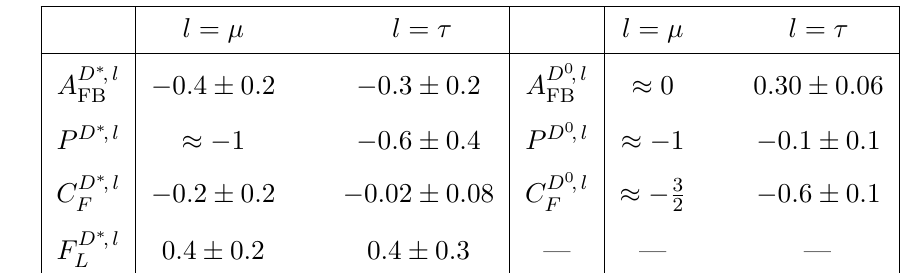
Figure 8 . Angular observables de(cid:12)ned in (3.10) for B c ! D 0 (cid:28) (cid:22) (cid:23) (cid:28) .